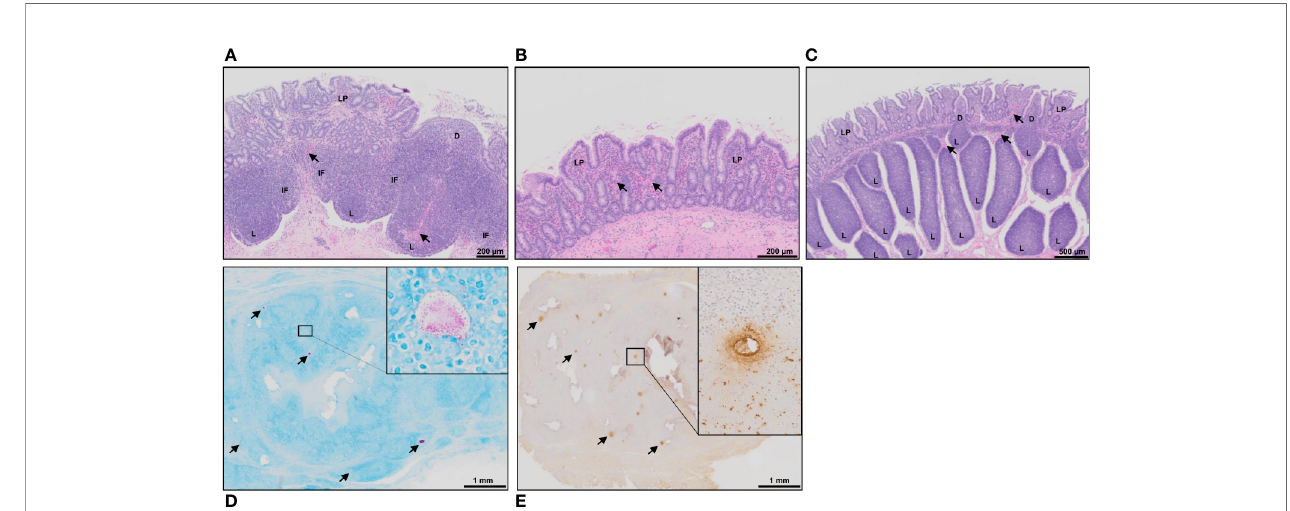
FIGURE 3 | Histology of intestinal tissue and subcutaneous vaccine injection site from Silirum vaccinated calves. (A) H&E staining of a discrete PP (DPP) and the (B) surrounding mucosa within a mid-jejunal segment, and a (C) continuous band of PP (CPP) within a terminal jejunum segment from a Silirum-vaccinated calf at 28 days post-MAP infection. Extravasated red blood cells (arrows) are visible in both mid- and terminal-jejunal segments, speci fi cally within the lamina propria, submucosal lymphoid follicles and interfollicular regions . (D) Fite ’ s acid-fast stain of a tissue section from the encapsulated subcutaneous mass collected at the Silirum vaccine injection at 84 days post-vaccination (28 days post-infection). Multiple foci of red staining (arrows) are dispersed throughout the encapsulated mass. Inset is a digital magni fi cation of a representative foci showing acid-fast bodies and amorphous material present as an aggregate and dispersed among surrounding cells. (E) Immunohistochemical stain with polyclonal Mycobacterium avium ssp. paratuberculosis (MAP) antisera of a tissue section from the encapsulated subcutaneous mass collected at the Silirum vaccine injection site. Multiple foci of brown staining (arrows) are dispersed throughout the mass. Inset is a digital magni fi cation of a single foci showing the diffuse brown staining in a localized acellular area and positive staining within surrounding cells. D, dome; IF, interfollicular region; L, lymphoid follicle; LP, lamina